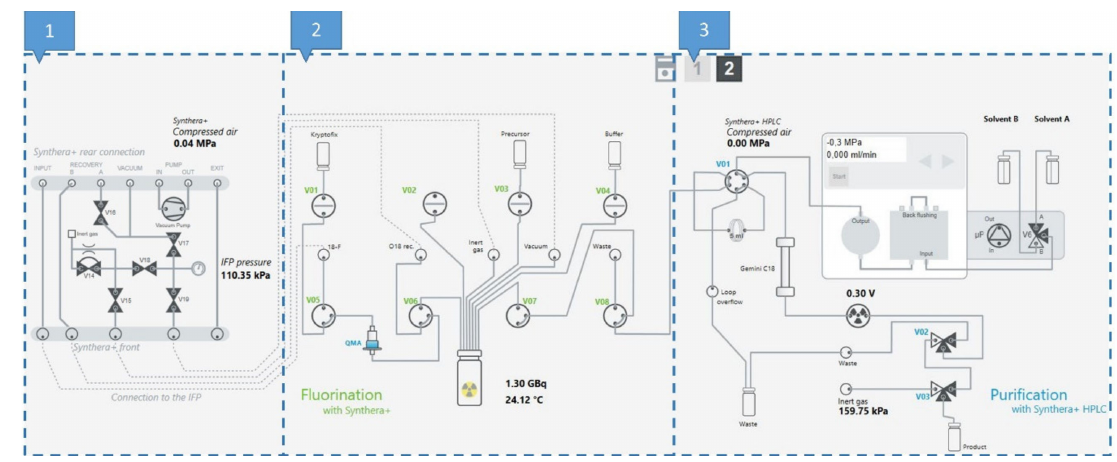
Figure 10. Setup of the Synthera ® + synthesis module used for the synthesis of [ 18 F]FE-PE2I. Part 1: gas flow and vacuum regulation. Part 2: liquid transfer, heating and activity measurements. Part 3: preparative HPLC purification and collection of the